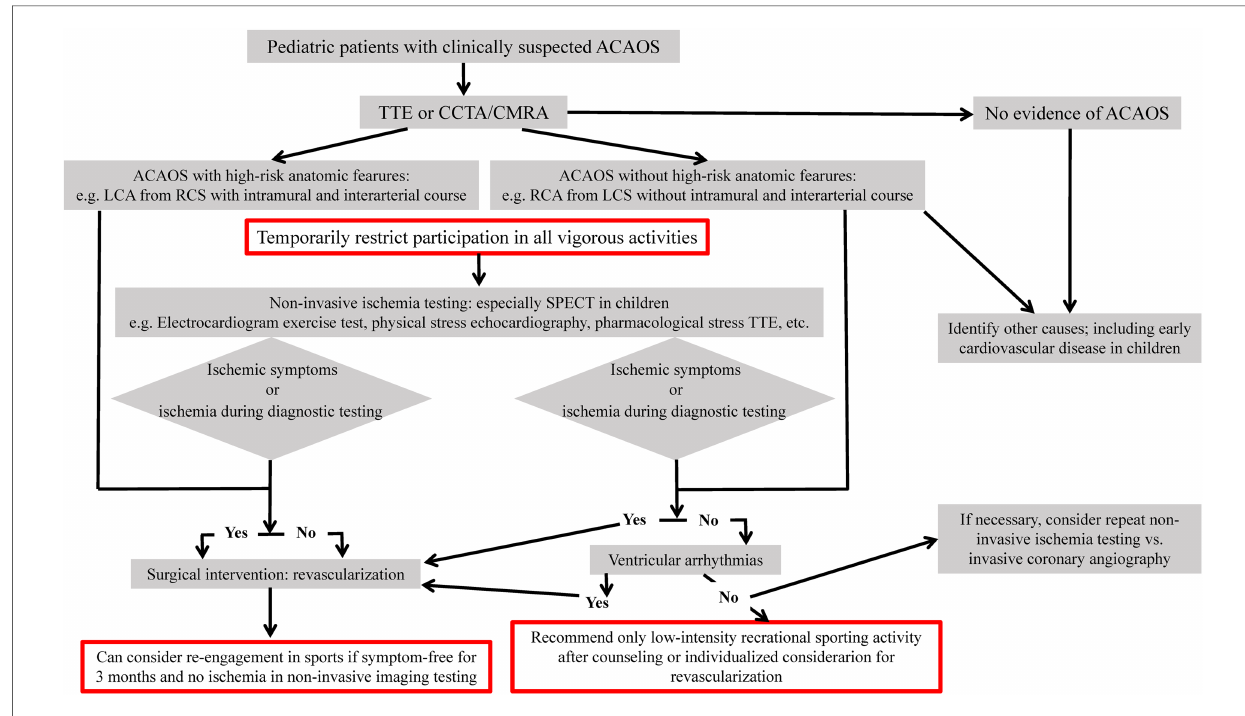
FIGURE 2 Flow chart for evaluation of clinical strategy of individuals with ACAOS. SPECT, Single photon emission computed tomography; PET, positron emission